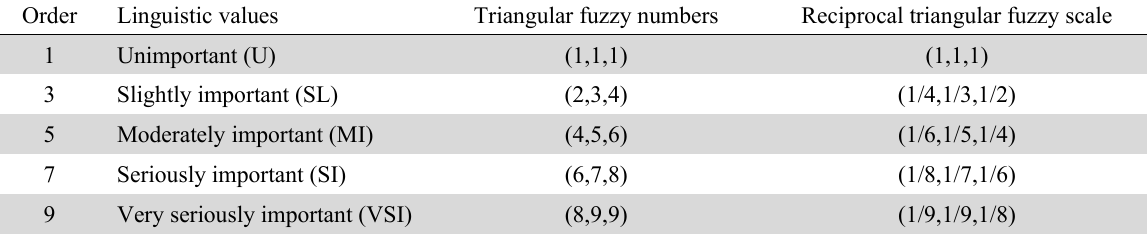
Triangular fuzzy conversation